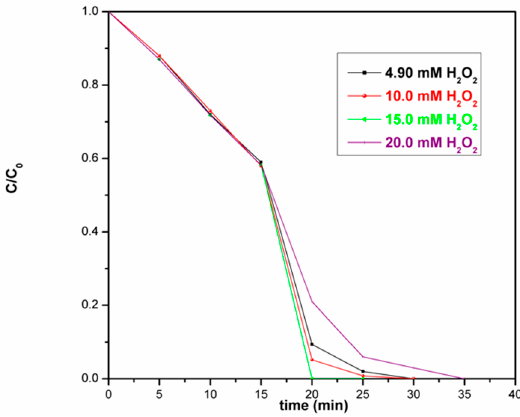
Figure 12. Effect of H 2 O 2 concentration on 4-CP removal by MFNNs. (Experiment conditions: [Cr(VI)] 0 = 10.0 mg/L, [4-CP] 0 = 100.0 mg/L, [MFNNs] = 0.20 g/L, pH = 3.0).